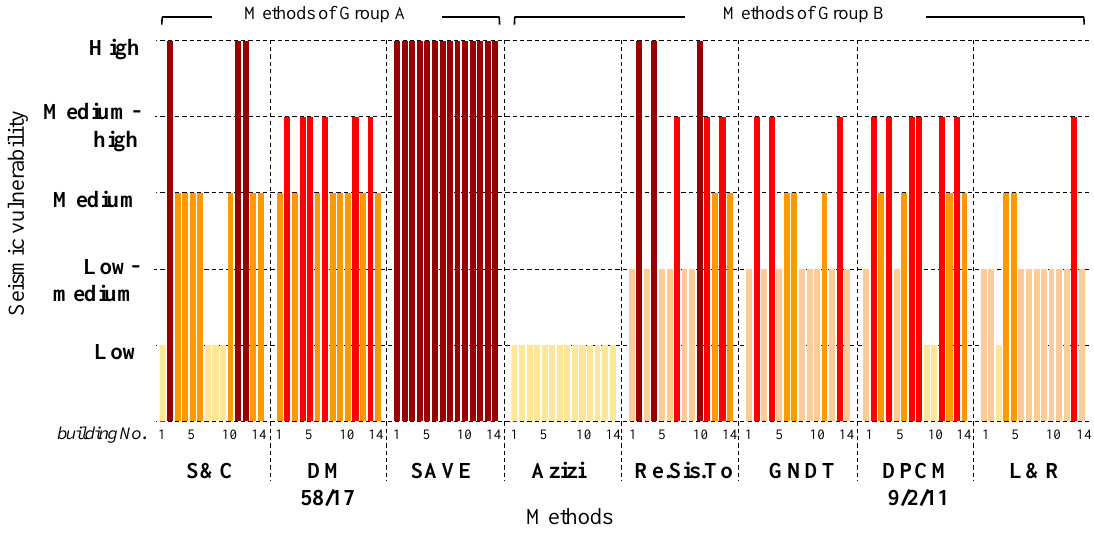
Figure 13. Overall comparison of vulnerability judgments coming from methods of Group A and B.